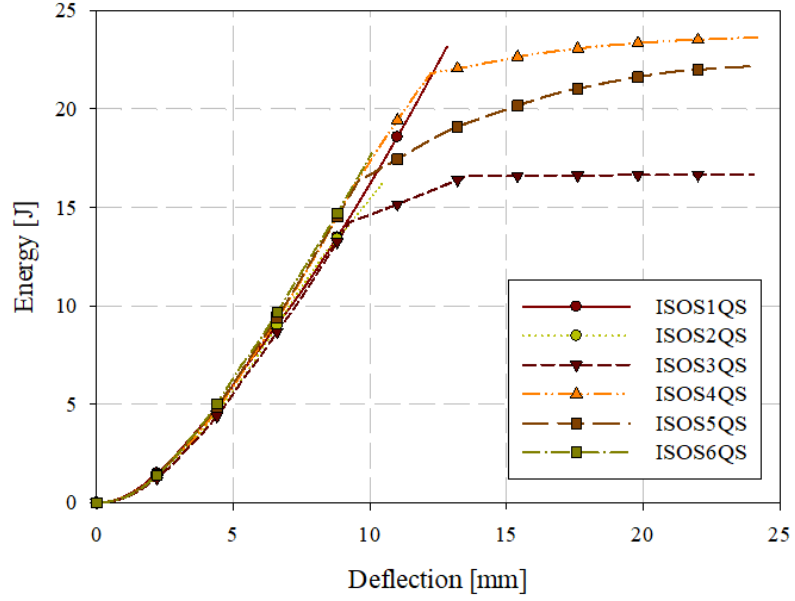
Figure 12. Quasi-static puncture energy-deflection responses.